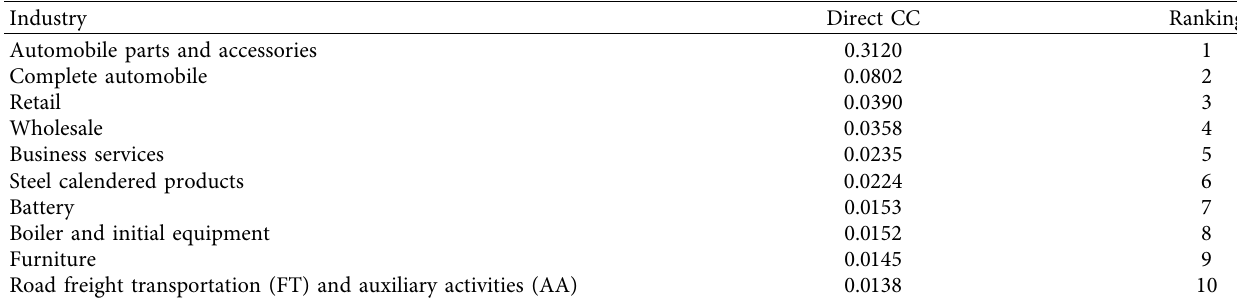
Table 3: Top 10 industries for direct CC.